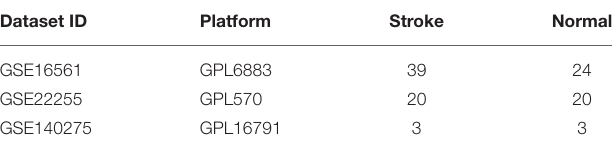
TABLE 1 | Ischemic stroke-related dataset from the GEO database. Dataset